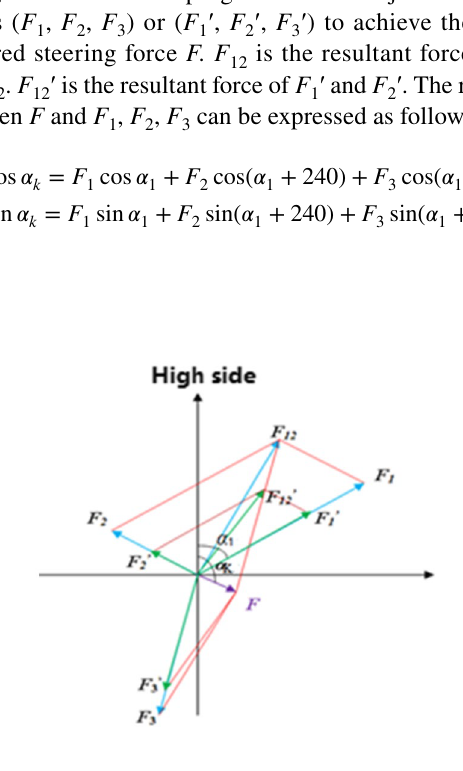
Fig. 8 Six areas of favorability based on the angle between the direc- tions of each pad force and the required steering